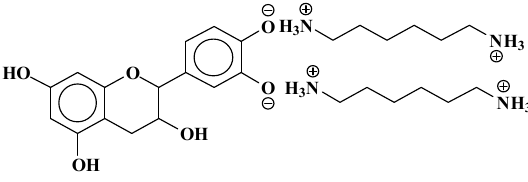
Figure 5. Example of ionic bonds salt structure at 524.6 Da.